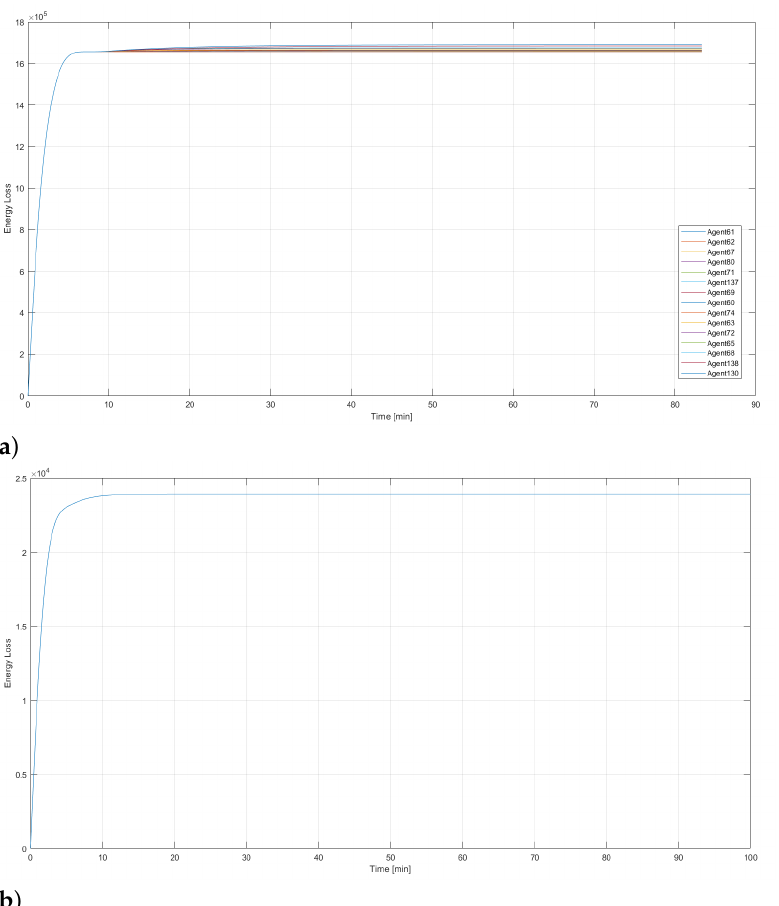
Figure 7. Energy Loss for ( a ) the best 15 neural network agents ( b ) the PID